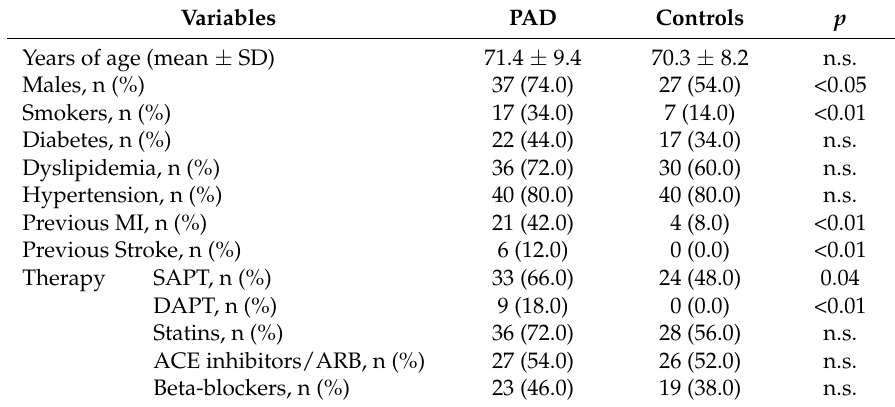
Table 1. Demographic and clinical characteristics of the studied